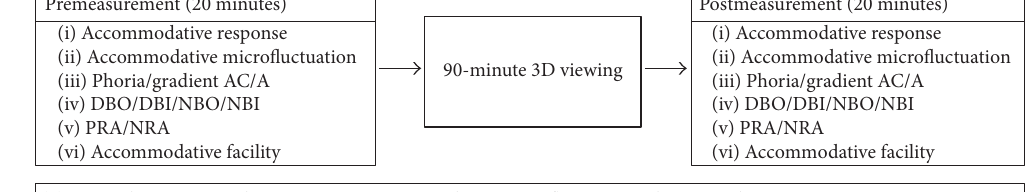
Figure 2: Illustration of our experimental